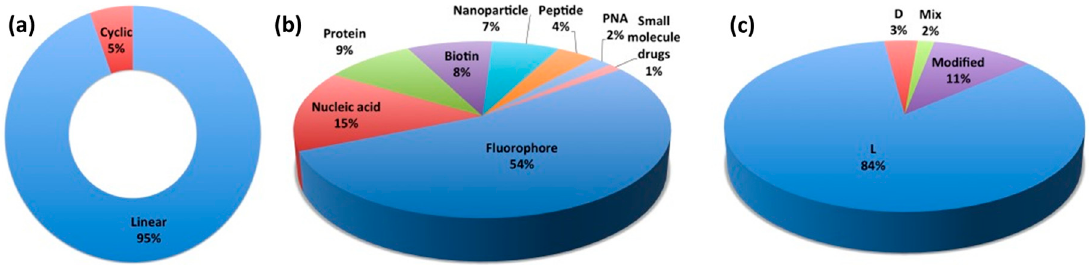
Figure 1. Statistical graphic representations depicting the distribution of cell-penetrating peptides (CPPs) reported in the literature (based on 1855 entries, of which 1699 are unique peptides) on the basis of the following: ( a ) linear and cyclic structure; ( b ) type of cargo delivered; and ( c ) chirality (taken from the CPP 2.0 database), taken from reference [12].